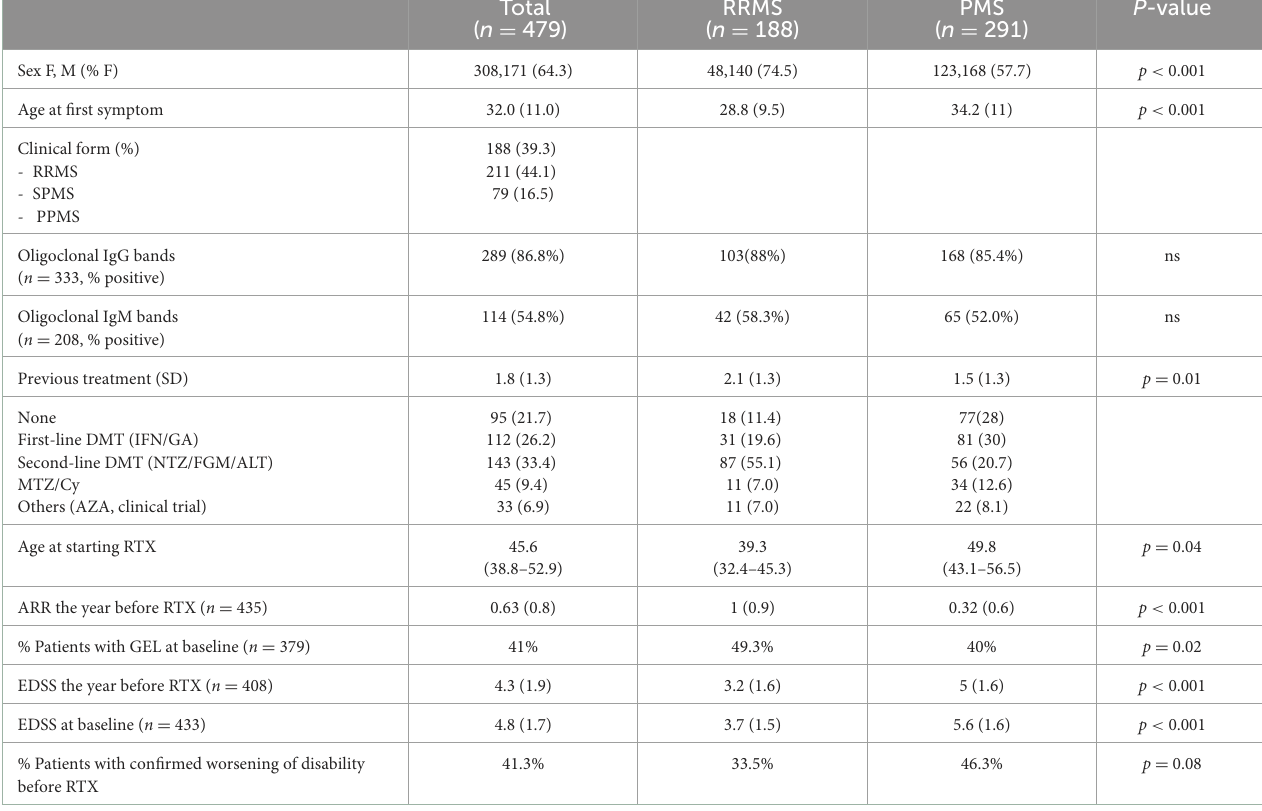
TABLE 1 Baseline clinical and demographic characteristics of the entire series and of RRMS, SPMS, and PPMS groups separately.